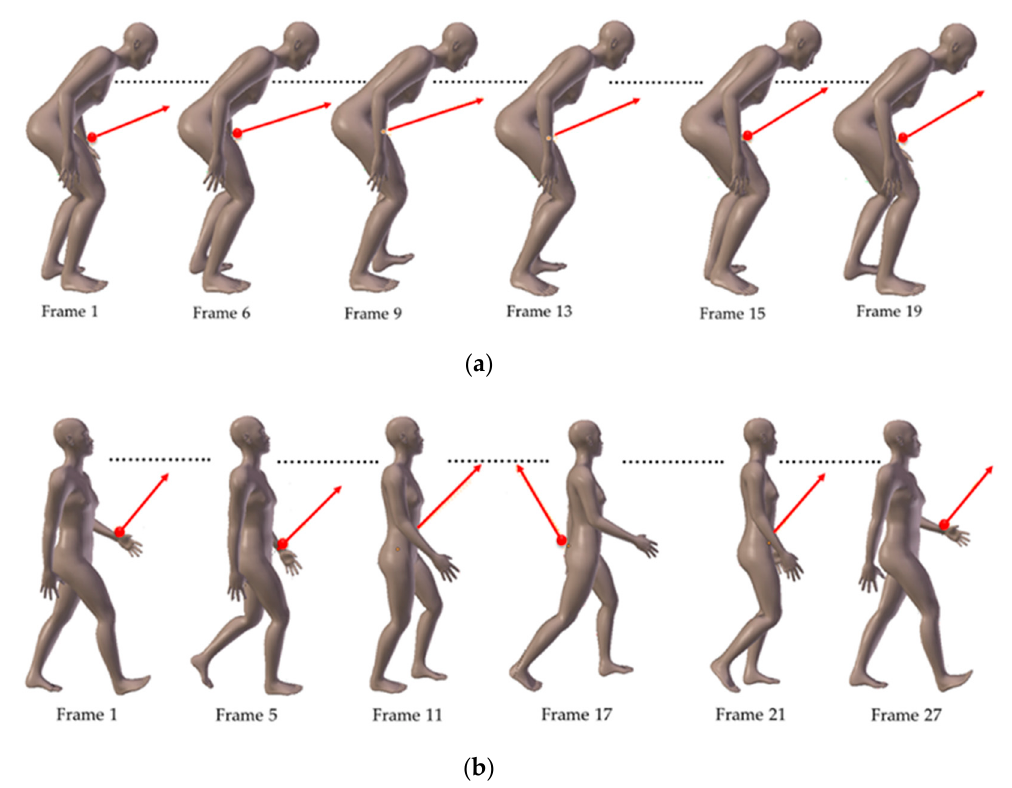
Figure 3. Illustration of walking cycle: ( a ) elderly model; ( b ) young model.